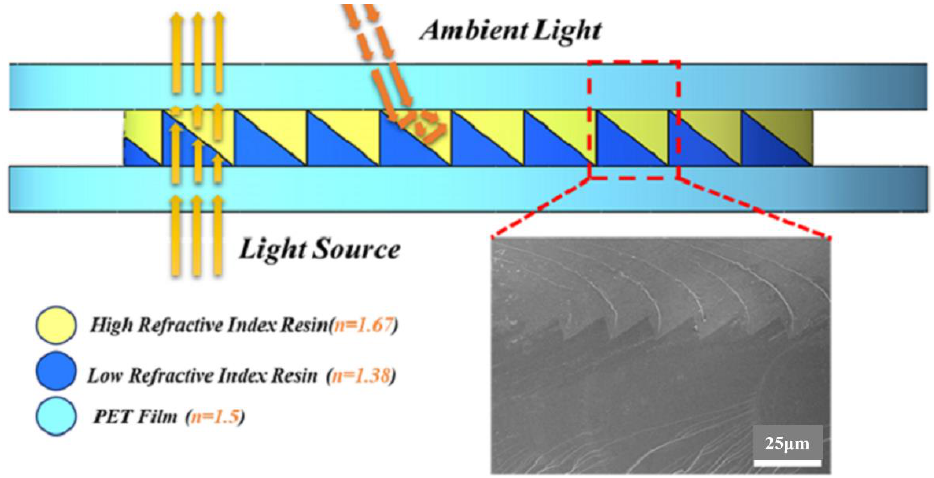
Figure 6. Schematic diagram of a composite SLARC consisting of high and low refractive index resins prepared by nanoimprint technology and light propagation. Reprinted with permission [71]; 2022, MDPI.